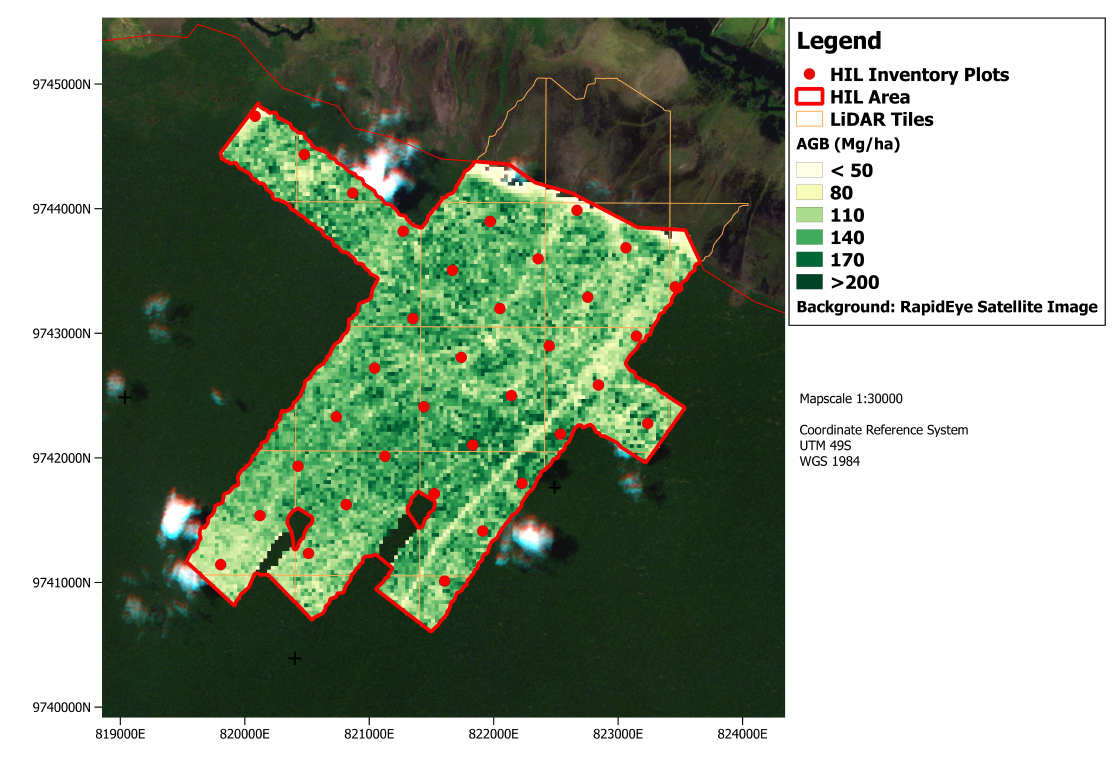
Figure 6. Map of ALS-assisted AGB predictions for the HIL area with 30m spatial